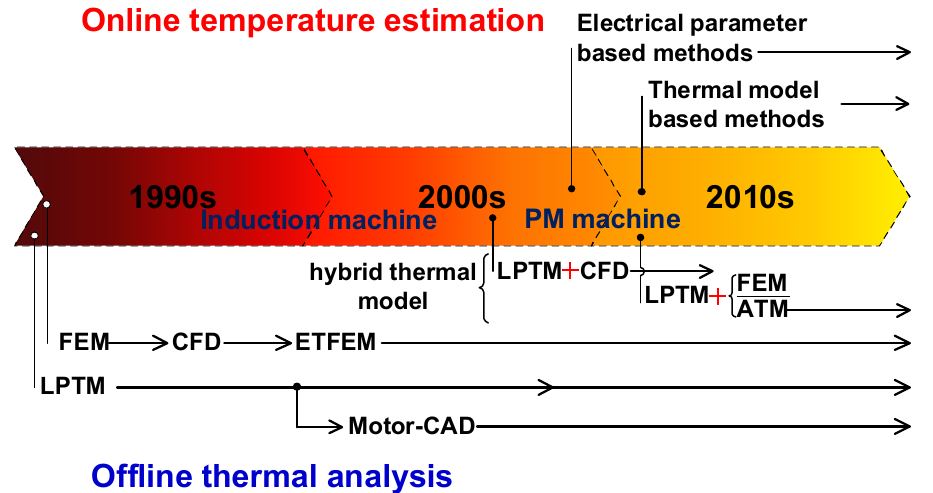
Figure 2. Development of thermal analysis for electrical machines in the last 30